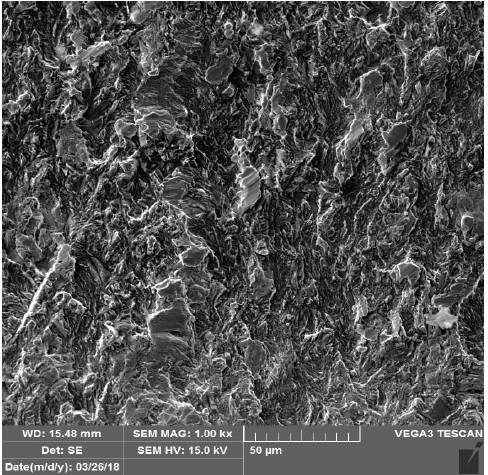
Figure 3. Fusion zone fractography after tensile test on sample C (TRIP). The measured microhardness values correspond to a chemical composition of an investigated materials and spotted structures. The lowest microhardness values were shown in the base material, samples A Figure 4, where the average microhardness value in the base material was 125 HV0.1, in thermally affected area the microhardness values raised to 179 HV0.1 and the weld metal showed an average microhardness of 231 HV0.1. The microhardness course of sample B is documented in Figure 5. On sample B (Figure 5) the lowest microhardness value in the base material 175 HV0.1 was measured. Microhardness peaks were recorded in the middle of the weld metal at 347 HV0.1. Samples marked C showed the maximum microhardness values. The average microhardness value of the base material was 242 HV0.1, the average value of 369 HV0.1 was measured in thermally affected area and the maximum values of 498 HV0.1 were measured in the weld metal (Figure 6).